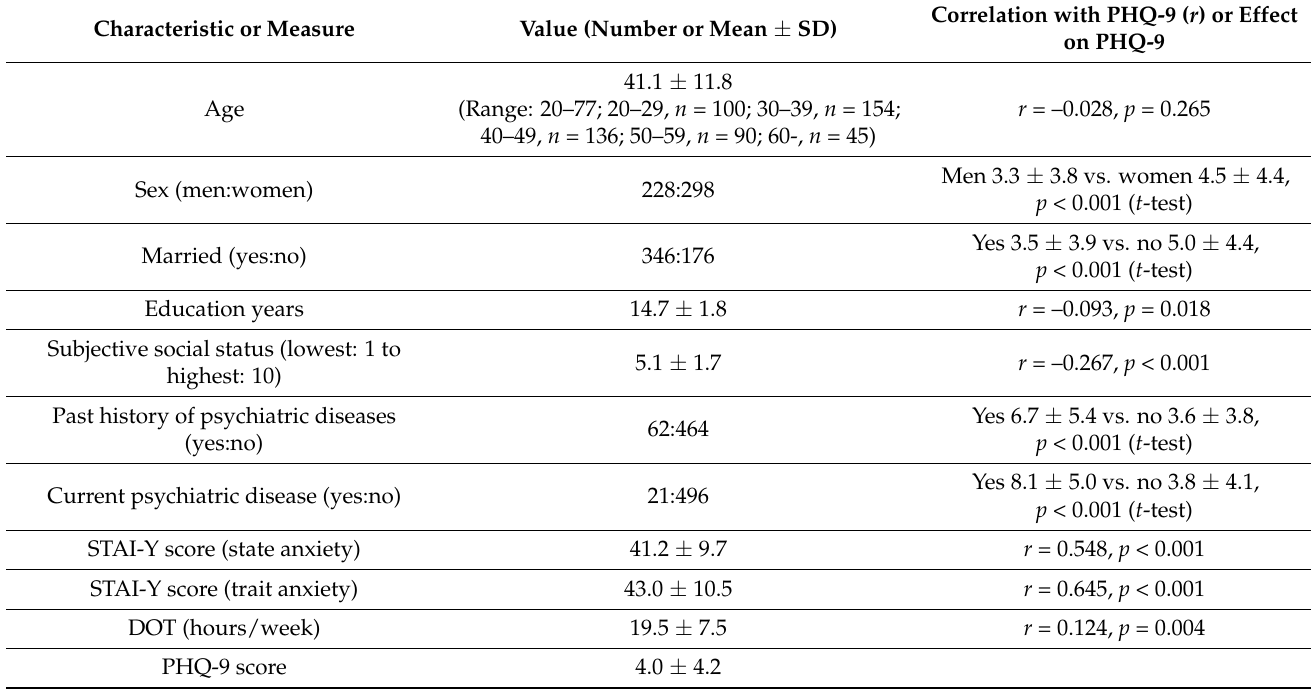
sive symptoms (PHQ-9 score) in 526 adult